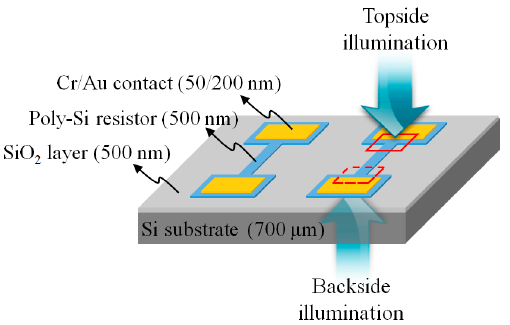
Figure 2. DUT design with a poly-Si micro resistor on a SiO 2 layer/Si substrate and the illumination directions for topside and backside measurements.